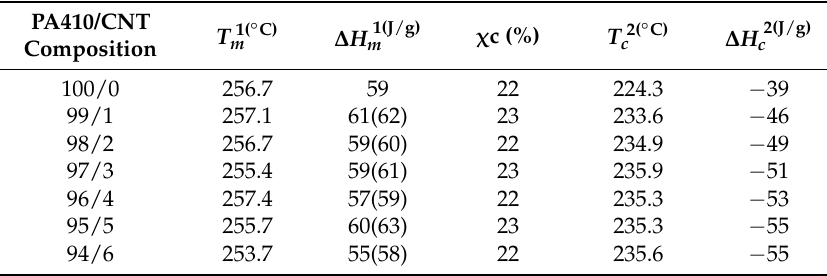
Table 3. Calorimetric parameters of PA410/CNT NCs.